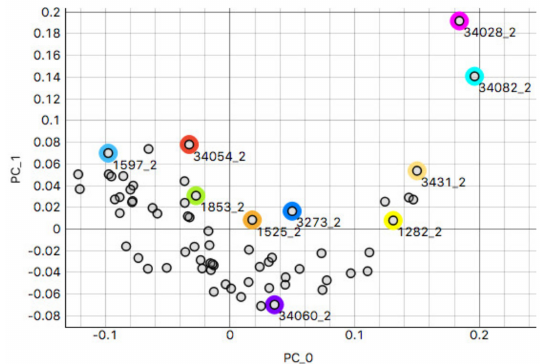
Figure 4. Scatterplot of skin examples along the first two principal components from the features explained below, the highlighted colors show random laboratories by code followed by tissue type code